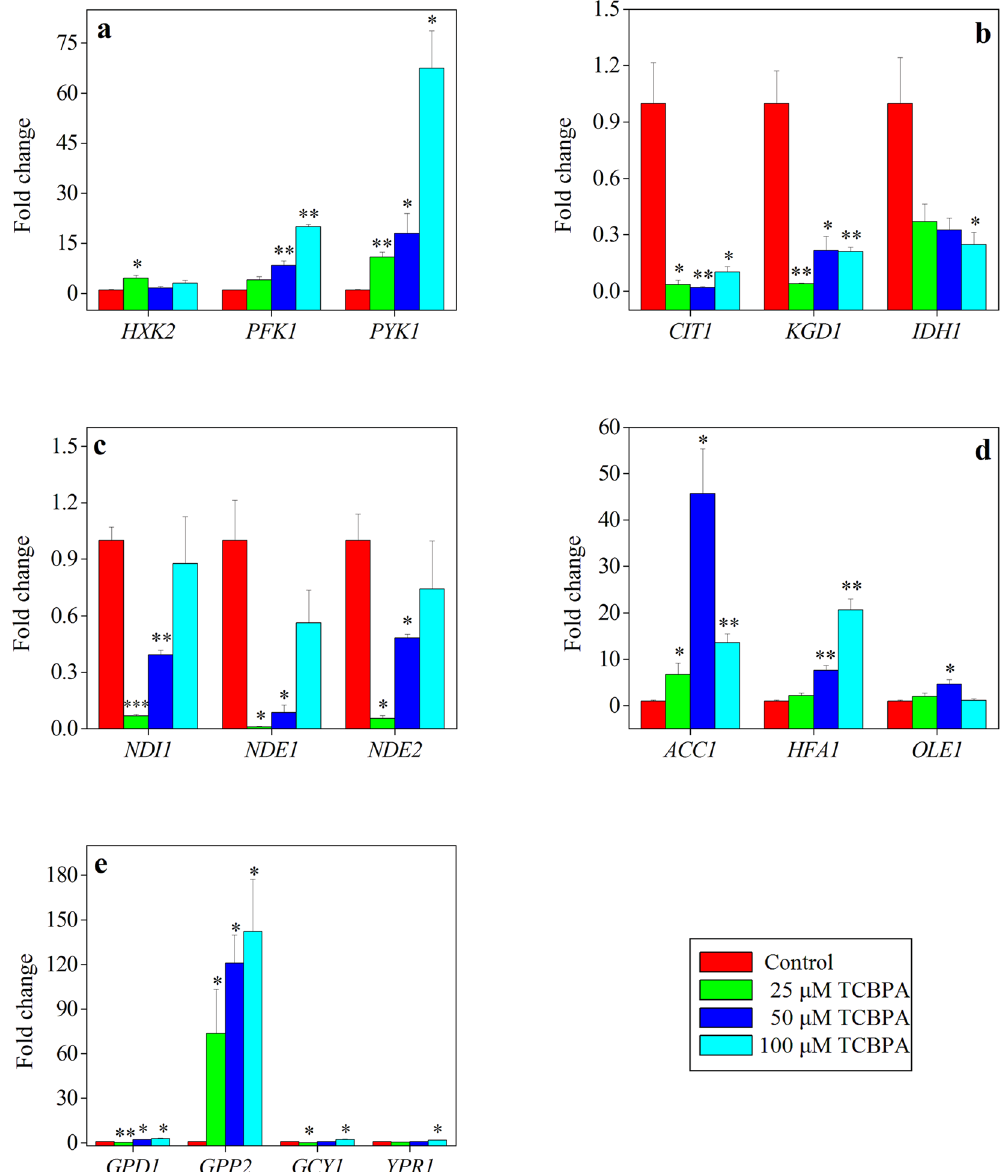
Figure 3. Change in the transcriptional levels of genes participating in the main metabolic pathway of S . cerevisiae between the control group and TCBPA-treated groups. ( a ) EMP pathway; ( b ) TCA cycle; ( c ) redox pathway; ( d ) fatty acid pathway; ( e ) glycerol pathway. All results were normalized to the ACT1 transcriptional level in the same sample. * P < 0.05 compared with the control group. ** P < 0.01 compared with the control group. *** P < 0.001 compared with the control